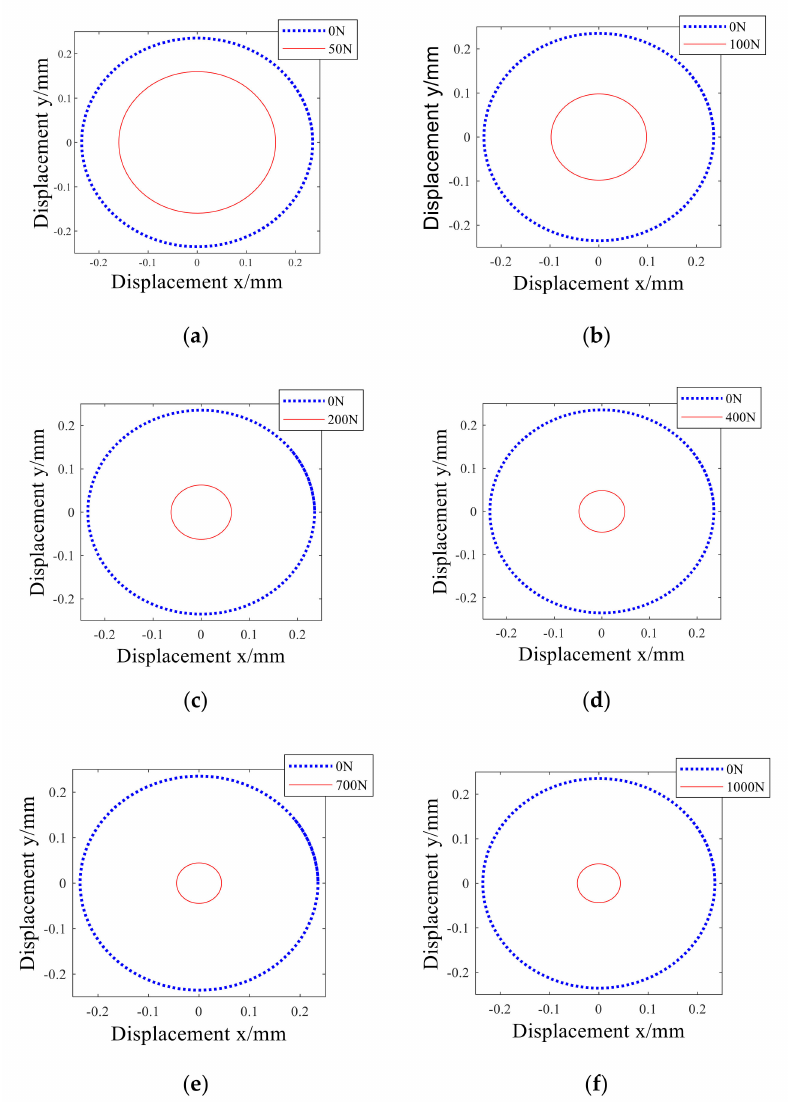
Figure 18. Steady-state response center orbit under ( a – f ) control forces at 6000 r / min, respectively 50 N, 100 N, 200 N, 400 N, 700 N and 1000